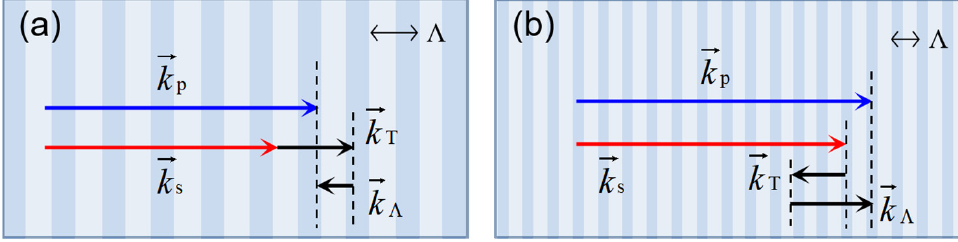
Figure 3. Orientation of wavevectors for forward ( a ) and backward ( b ) QPM.